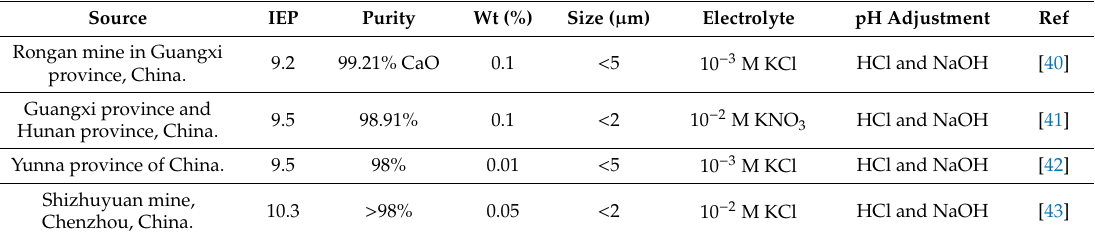
Table 5. IEP calcite values and their measurement operating conditions. Source